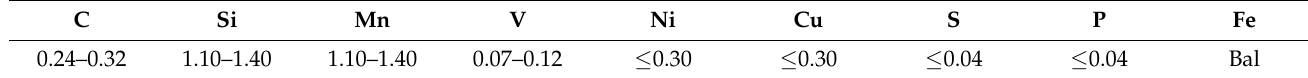
Table 1. Chemical composition of the laser cladding matrix 27SiMn (wt%).